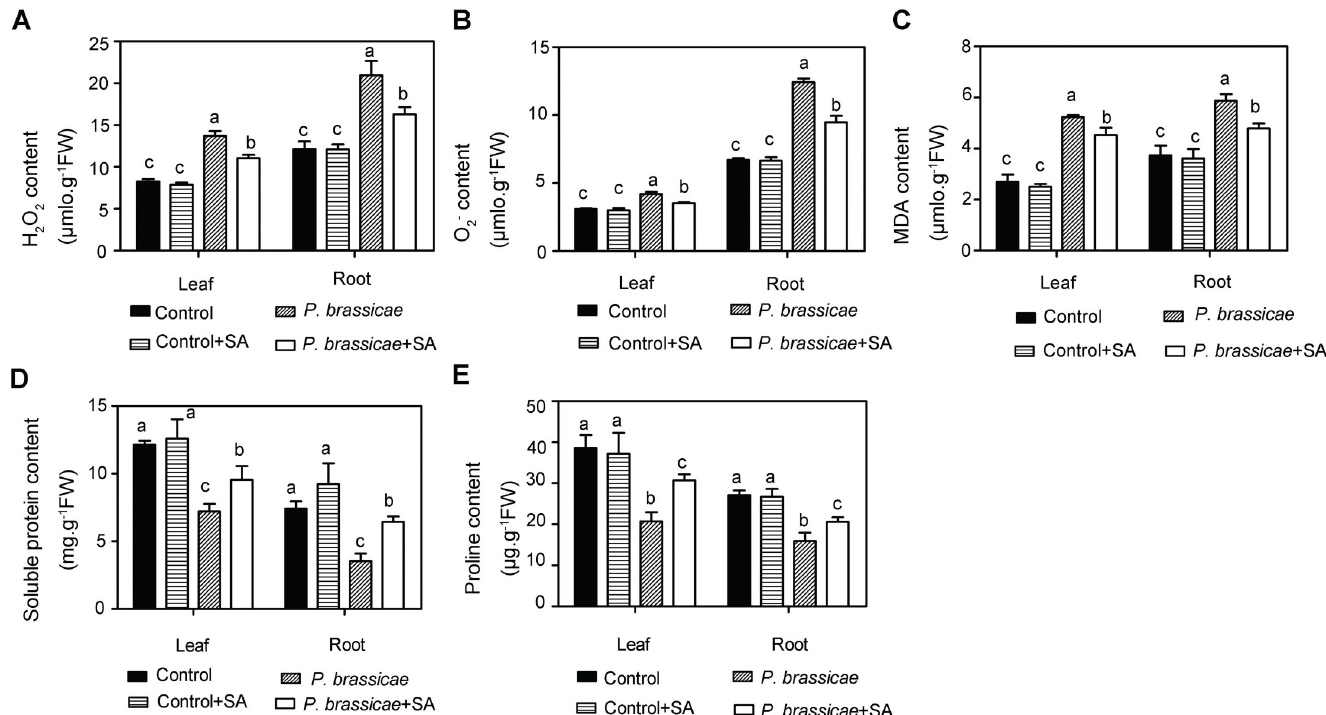
Fig 2. ROS, soluble protein, and proline contents in pakchoi. H 2 O 2 (A) , O 2 � – (B) , MDA (C) , soluble protein (D), and proline contents (E) in leaves and in roots were presented. The third leaves and whole roots were harvested for analysis, respectively. Data shown represent mean ± SD (n = 3). Different letters indicate significance (Tukey’s HSD test, P <